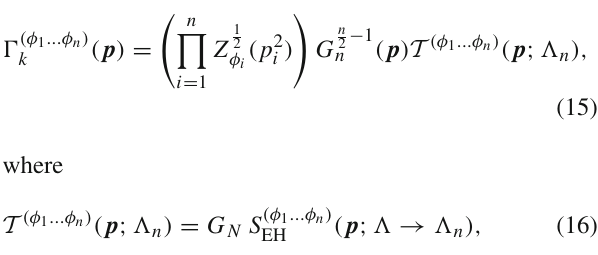
, ..., p φ ) denotes n 1